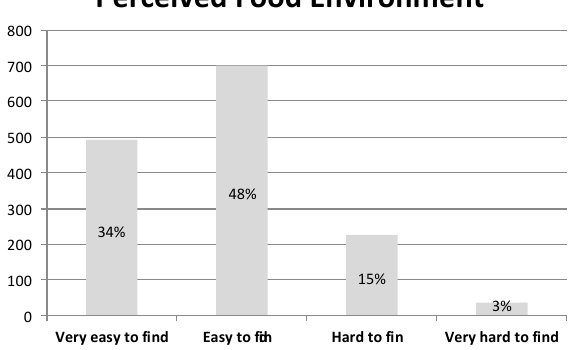
Figure 3. Frequency Distribution of the Perceived Food Environment. N = 1435.